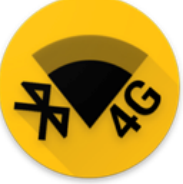
Figure 6. Icon of the implemented app FURI.